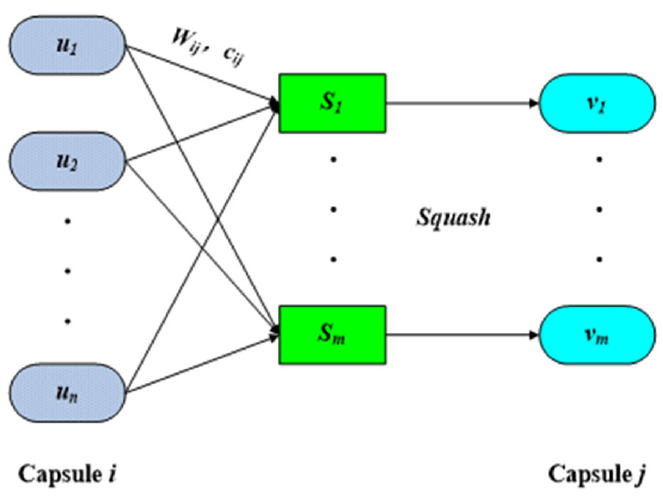
Figure 5. Information transmission between capsules [31].